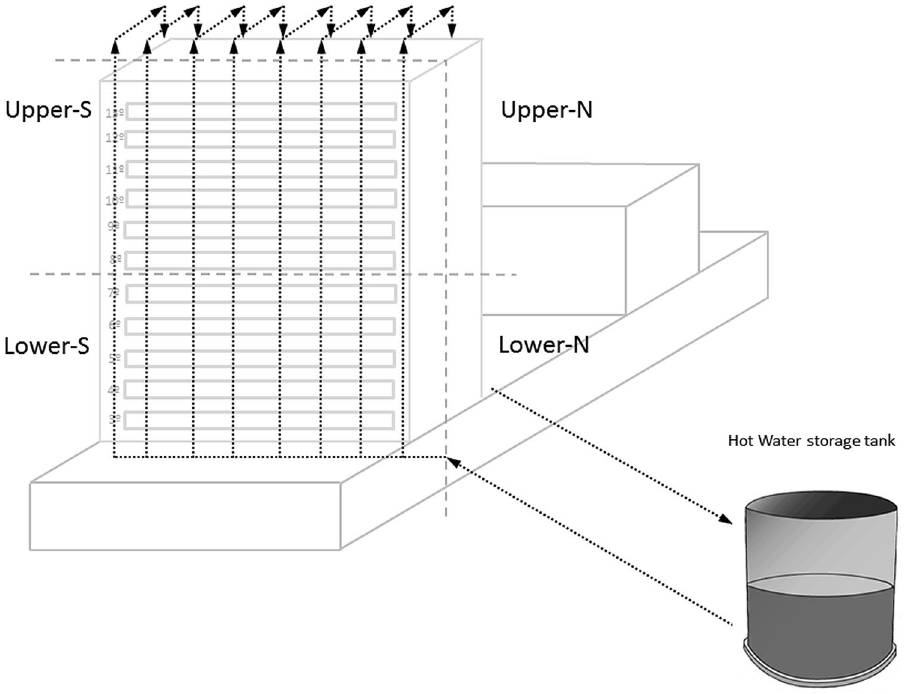
Figure 3. Diagram of hot water circuit 2. The arrows represent the direction of the water. The building is divided into four areas: Lower-S (Lower-South), Upper-S (Upper-South), Upper-N (Upper-North) and Lower-N